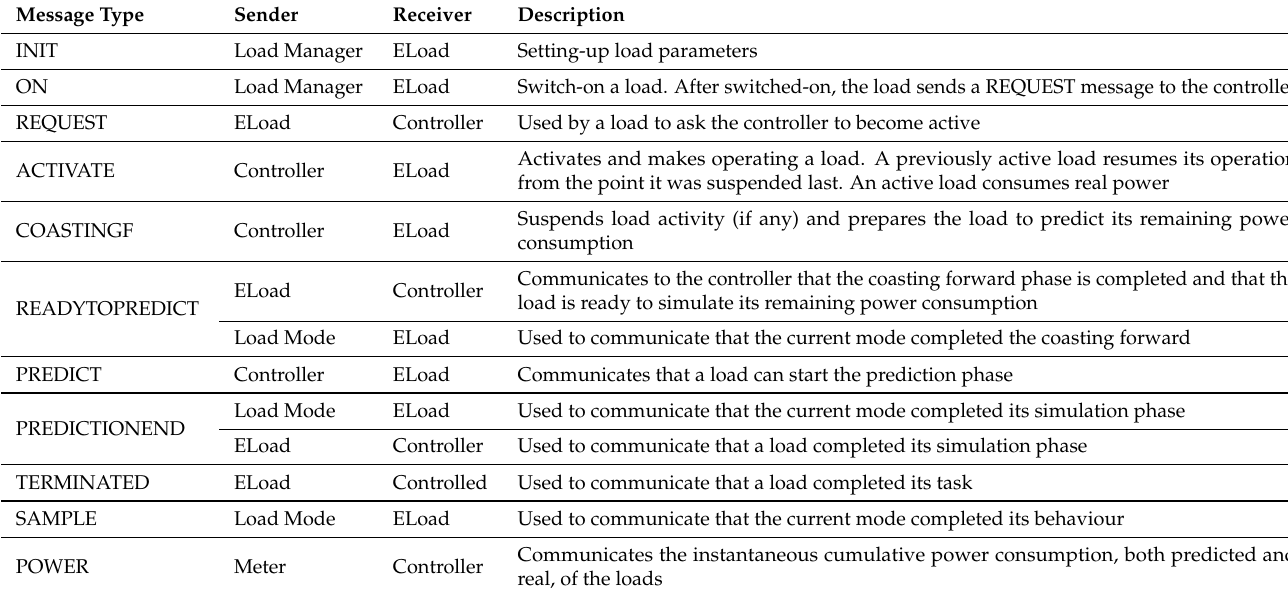
Table 1. Messages managed by the actors’ templates of U PPAAL